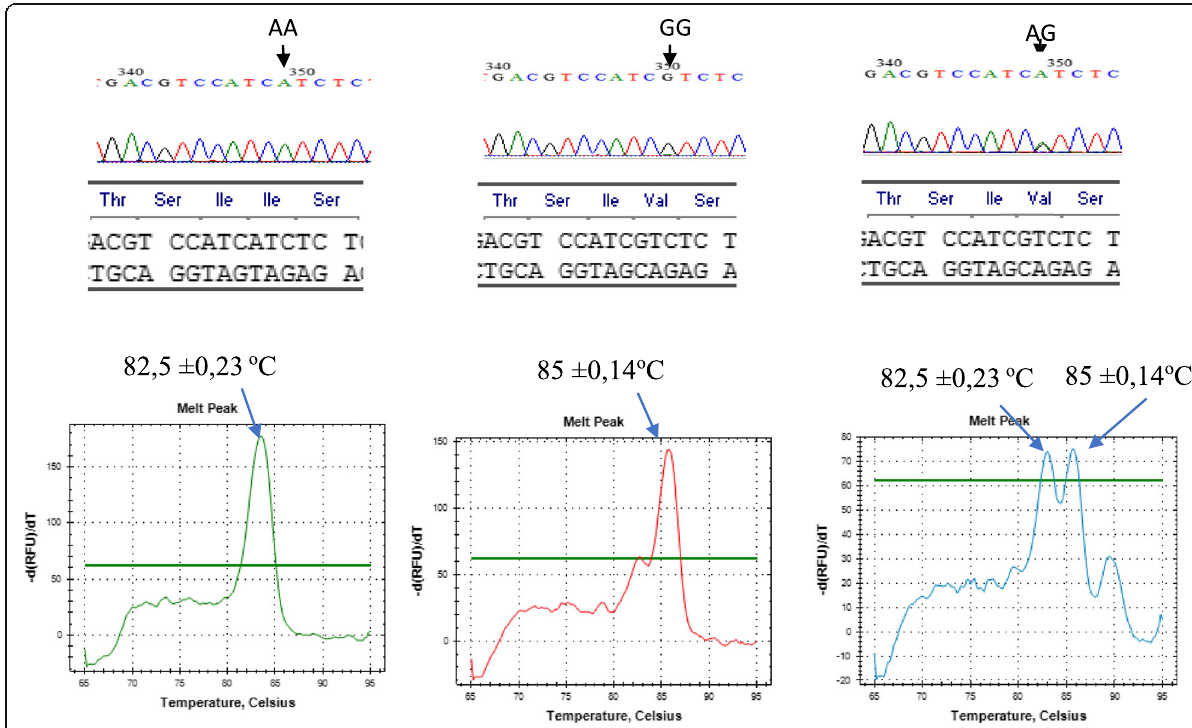
Fig. 2 SYBR Green I-based real-time PCR analysis for the detection of SNP and non-SNP HER-2 Ille655Val